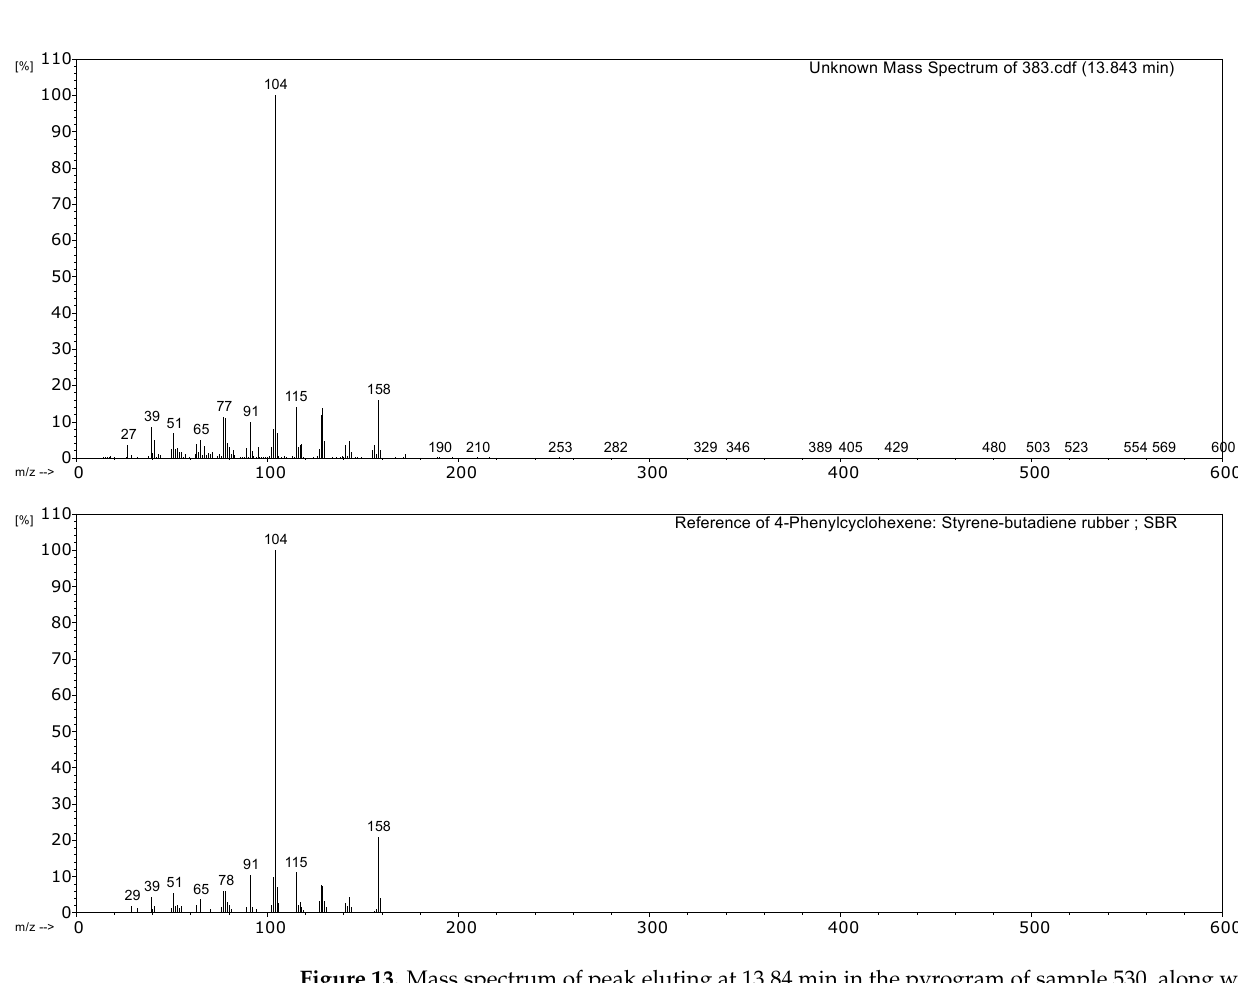
with the peaks at 12.46 min [1 ‐ chloro ‐ 5 ‐ (1 ‐ chlorovinyl)cyclohexene), Figure 15] and 12.51 min [1 ‐ chloro ‐ 4 ‐ (1 ‐ chlorovinyl)cyclohexene, Figure 16], both dimers of chloroprene, are